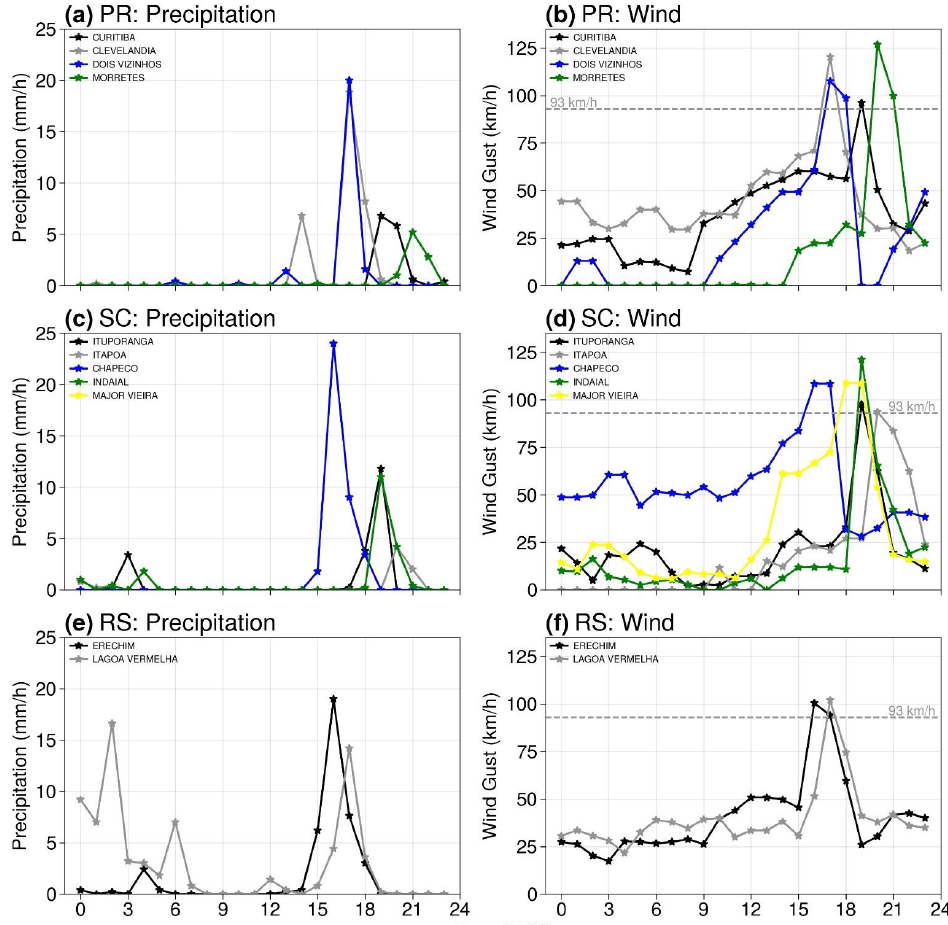
Figure 13. ( a , c , e ) Hourly precipitation (mm h −1 ) and ( b , d , f ) wind gusts (km h −1 ) at 10 m registered on 30 June 2020. In ( b , d , f ) is also shown the threshold of wind intensity (93 km h − 1 ) for severe thunderstorms. Top panels correspond to the data of four meteorological stations of Paraná state, ( b ) middle panels to five stations of Santa Catarina state, and ( c ) bottom panels to two stations of Rio Grande do Sul state.